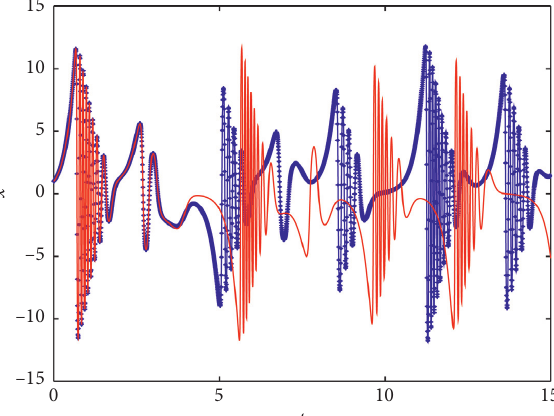
Figure 22: Sensitivity due to the variation of y ( 0 ) from y ( 0 ) � 1 to y ( 0 ) � 1 . 0001.